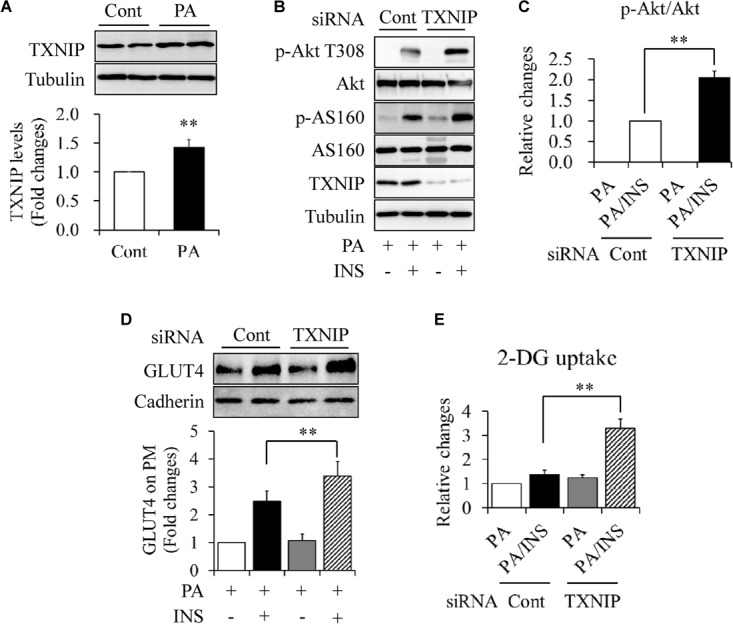
Impacts of TXNIP on PA-induced insulin resistance in C2C12 myotubes. (A) Effect of PA on TXNIP protein levels. (B,C) Effect of TXNIP knockdown on insulin (INS)-stimulated Akt phosphorylation. (D) Effect of TXNIP knockdown on INS-stimulated GLUT4 translocation on plasma membrane. (E) Effect of TXNIP knockdown on INS-stimulated 2-deoxy-D-glucose (2-DG) uptake. N = 4. ∗∗p < 0.01 vs. control (Cont) group or the indicated group.